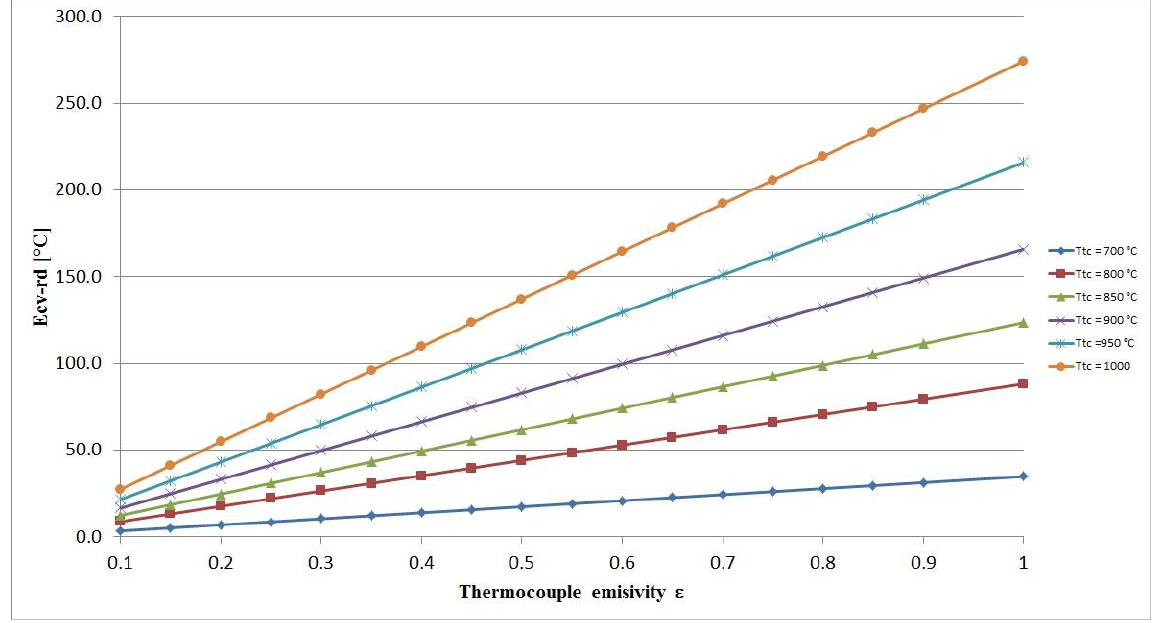
Figure 3. Radiation convection error estimated for a wall temperature of 600